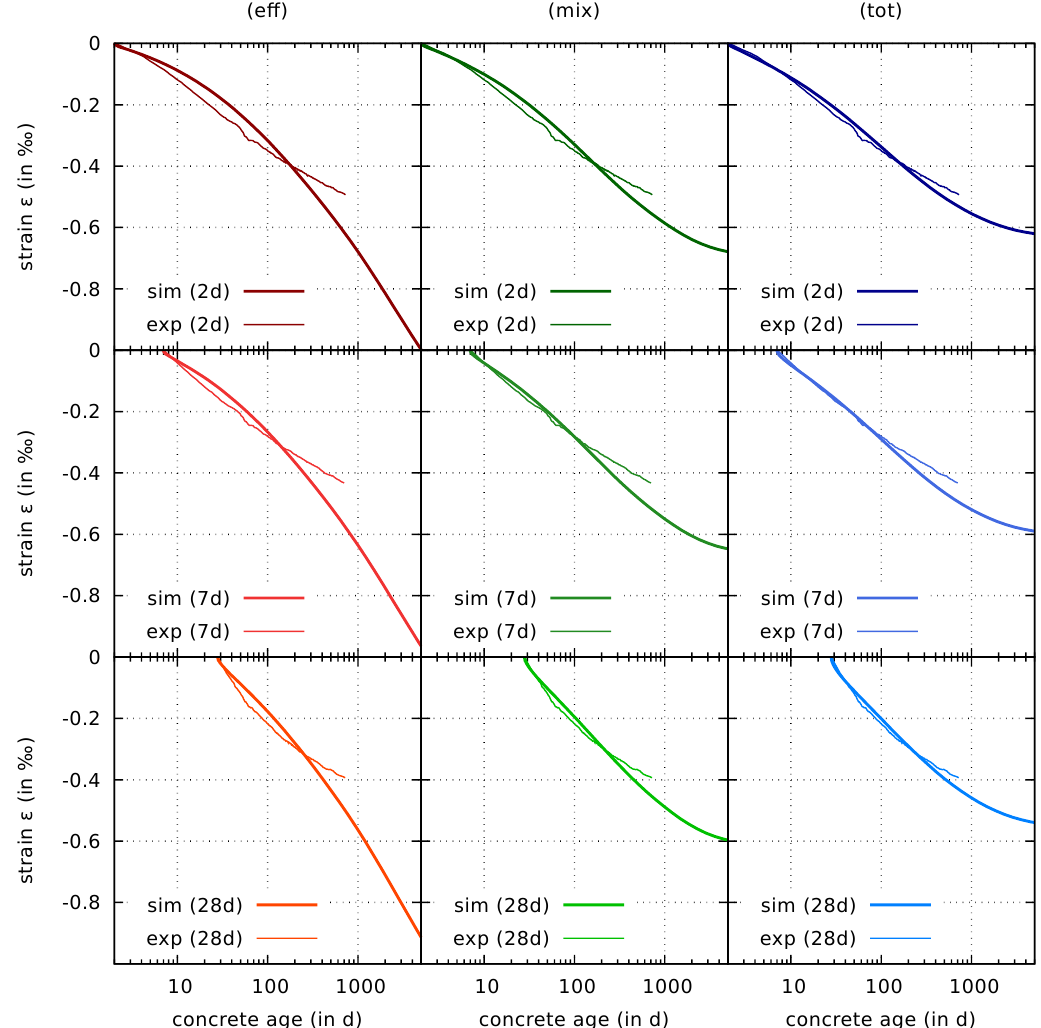
Figure 9. Computed and measured [8,9] evolution of the drying shrinkage for drying started at concrete ages of 2 days (first row), 7 days (second row), and 28 days (third row), respectively, for shrinkage formulations based on effective stress (eff), mixed stress (mix), and total stress